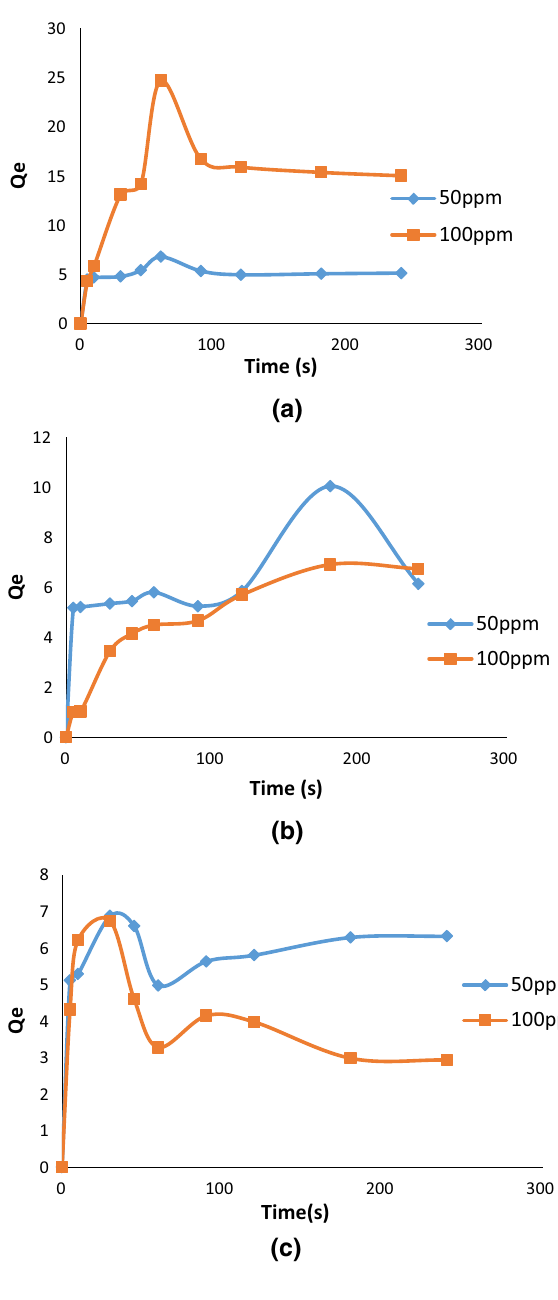
Fig. 6 a Time profile diagram for Cr(VI)//G (V = 25 ml, T = 300 K), b time profile diagram for Cr(VI)//AC, c time profile diagram for